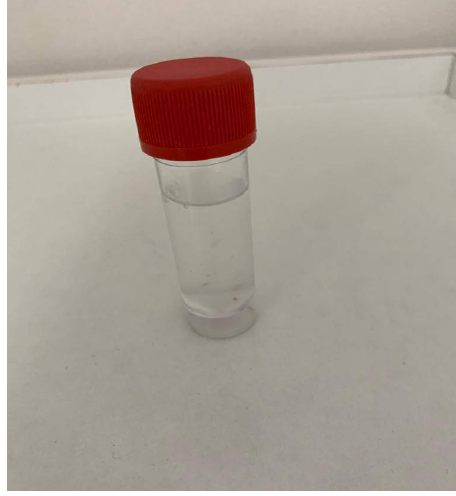
Figure 1. Patient stool’s aspect.